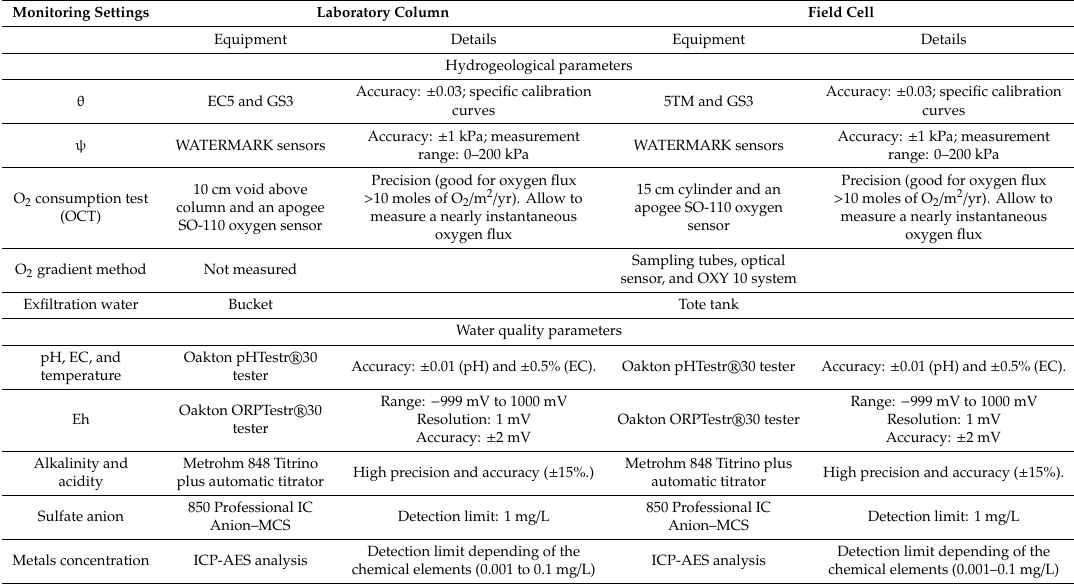
Table 2. Equipment and monitoring approach used for the CCBE column and field